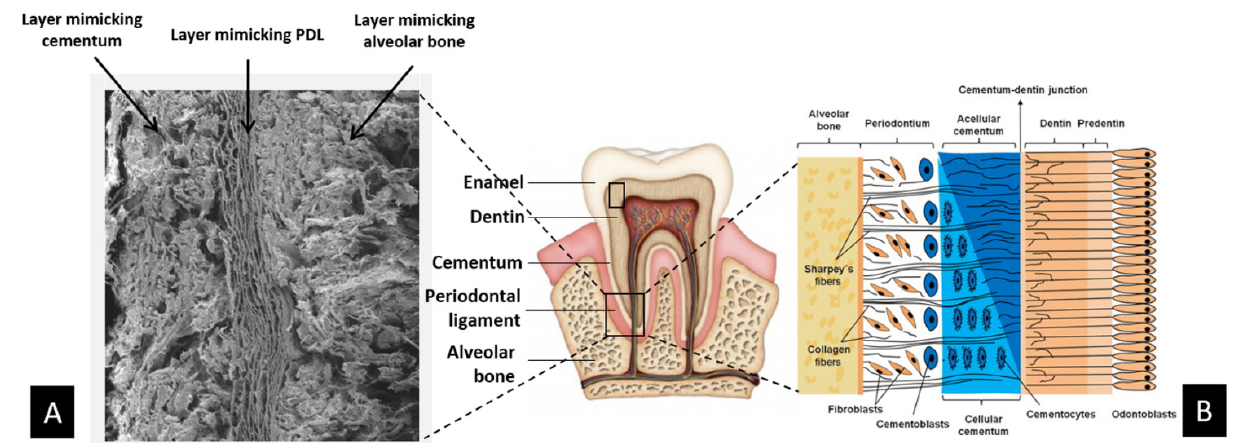
Figure 4. Scheme of multifunctional hybrid scaffold for periodontal regeneration: ( A ) SEM images showing at the microscale the multilayer scaffold made of three biomaterials mimetic of cementum, periodontal ligament, and alveolar bone; ( B ) details of the complex structure of natural periodontal tissue that inspired the fabrication of the three-layer biomimetic periodontal scaffold.